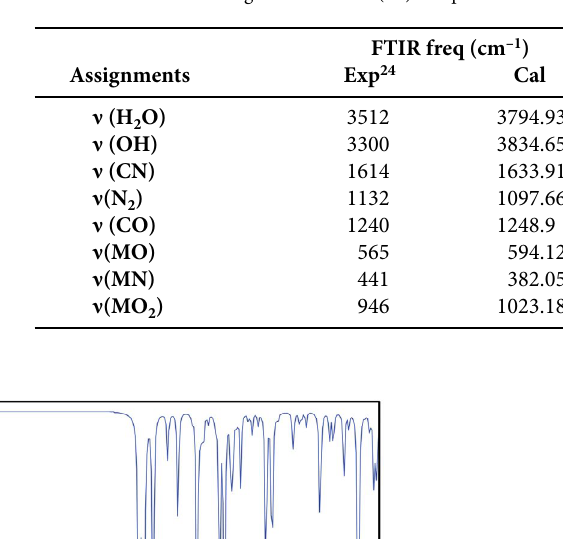
Table 4. The experimental and theoretical vibrational wavenumbers and intensities for the ligand and its Mo (VI) complex.